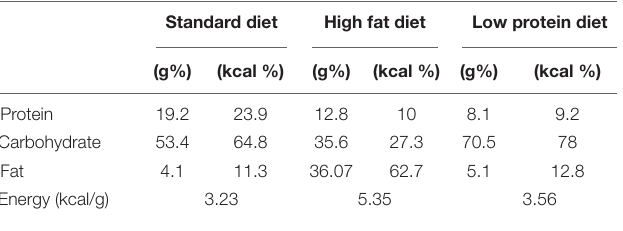
TABLE 1 | Composition of the diets used in the